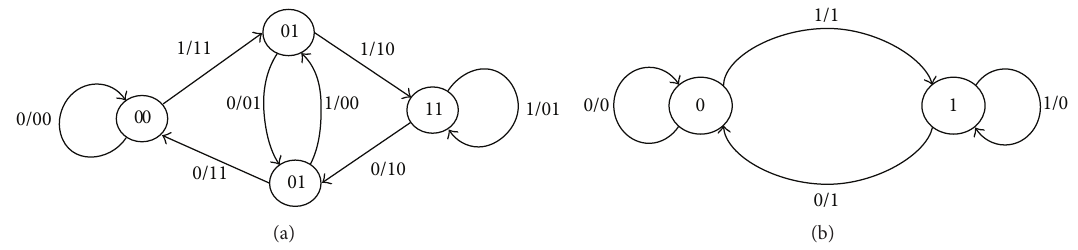
Figure 8: Reduced state diagram by the proposed algorithm (a) for CT { RT / CT } and (b) for RT { Input / RT } .